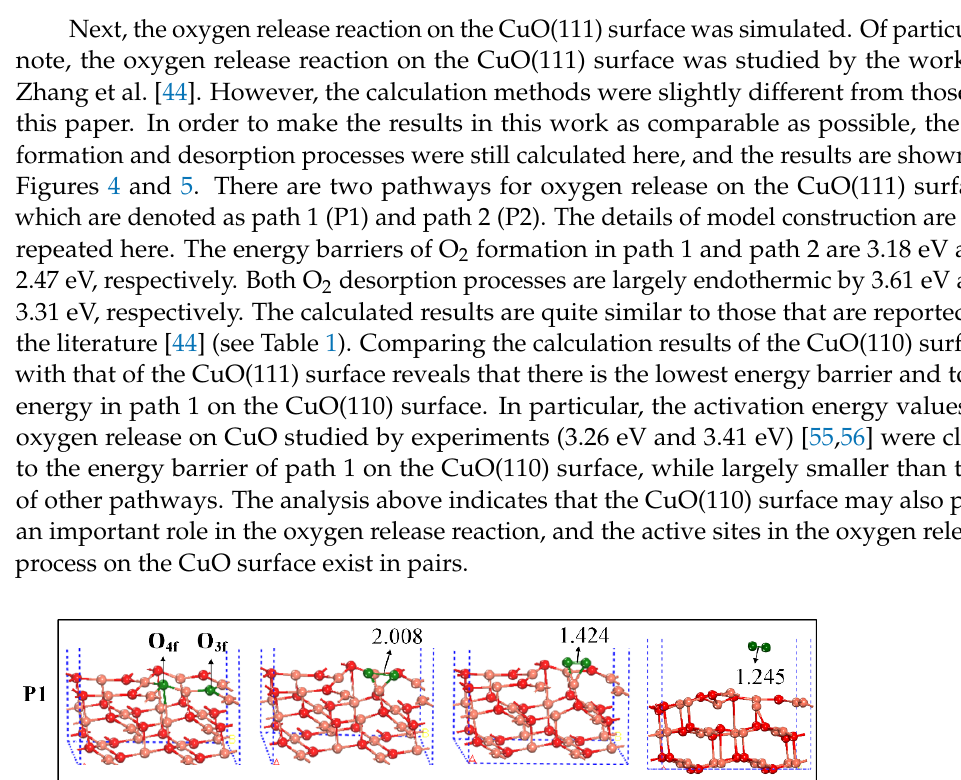
Figure 4. The initial state (IS), transition state (TS), intermediate state (IM), and final state (FS) structures for the O 2 formation and O 2 desorption processes in different pathways on the CuO(111) surface. The bond lengths are presented in Å. The salmon pink and red spheres denote Cu and O atoms,